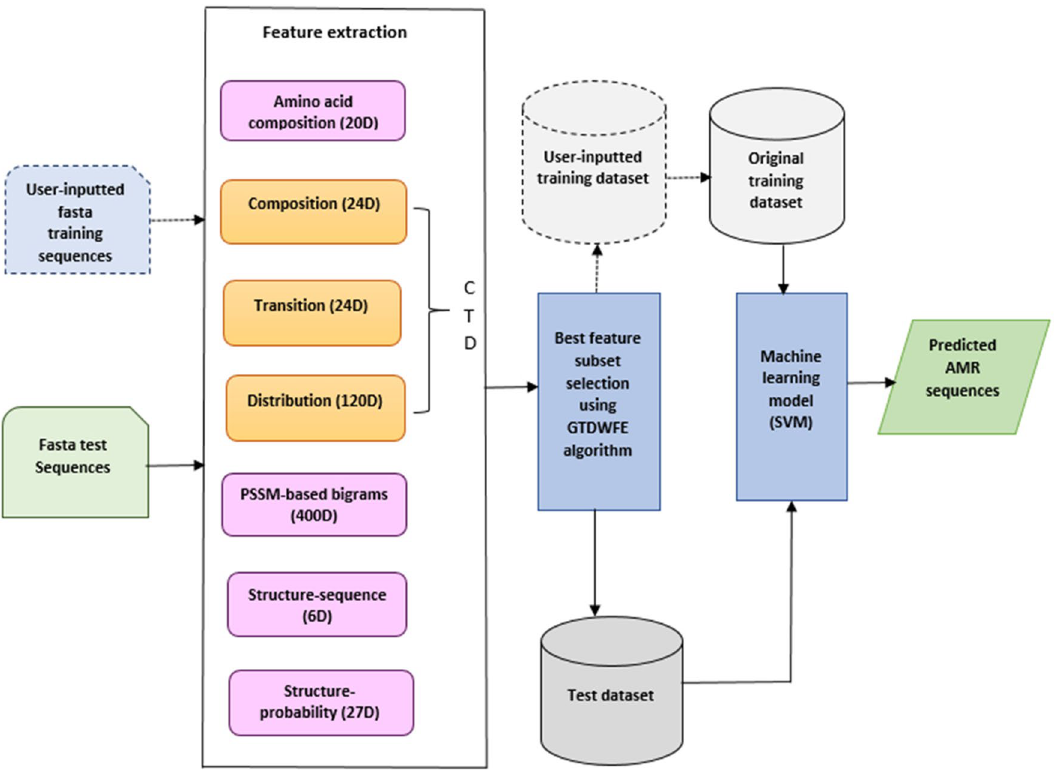
Figure 1. The components of PARGT. Components outlined by dotted lines indicate additional training samples supplied by a user.